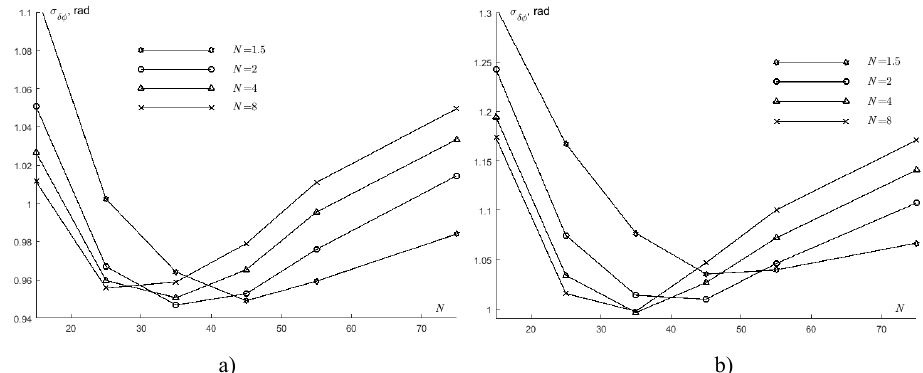
 dependencies on the filter block size for different  values for the Goldstein Fig. 5.  algorithm: a) scene N 4; b) scene N